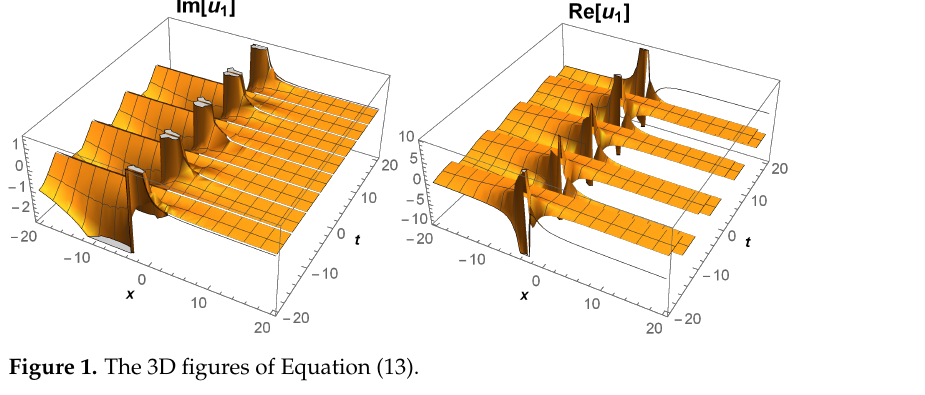
Figure 1. The 3D figures of Equation